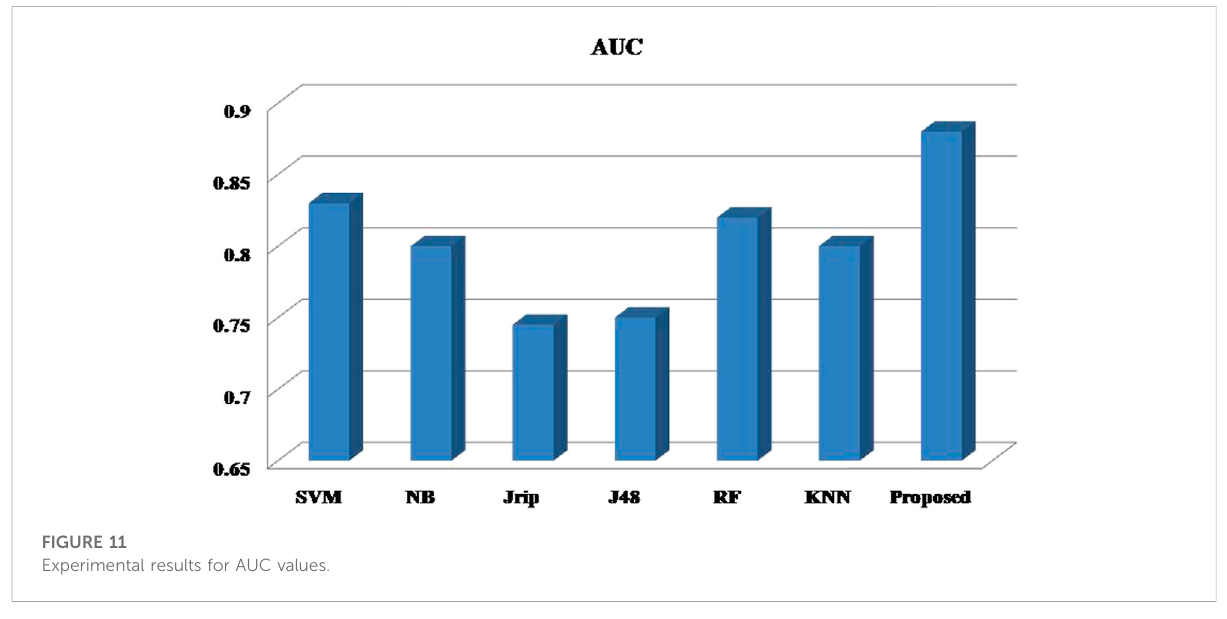
FIGURE 11 Experimental results for AUC